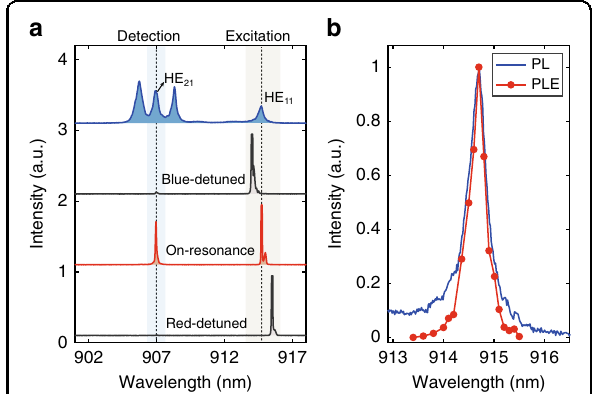
Fig. 4 Dual resonances enhanced up-converted excitation. a High-power above-band PL spectrum of a pillar with a diameter of 2 μ m (blue) and low-power PL spectra of a QD excited under dual resonances (red) and single resonance conditions (black). b Normalized high-power PL spectrum of HE 11 mode (blue) and PLE spectrum of the QD acquired by sweeping the excitation laser through HE 11 mode and detecting the QD emission intensity (red), the power of excitation laser is kept constant for PLE measurement